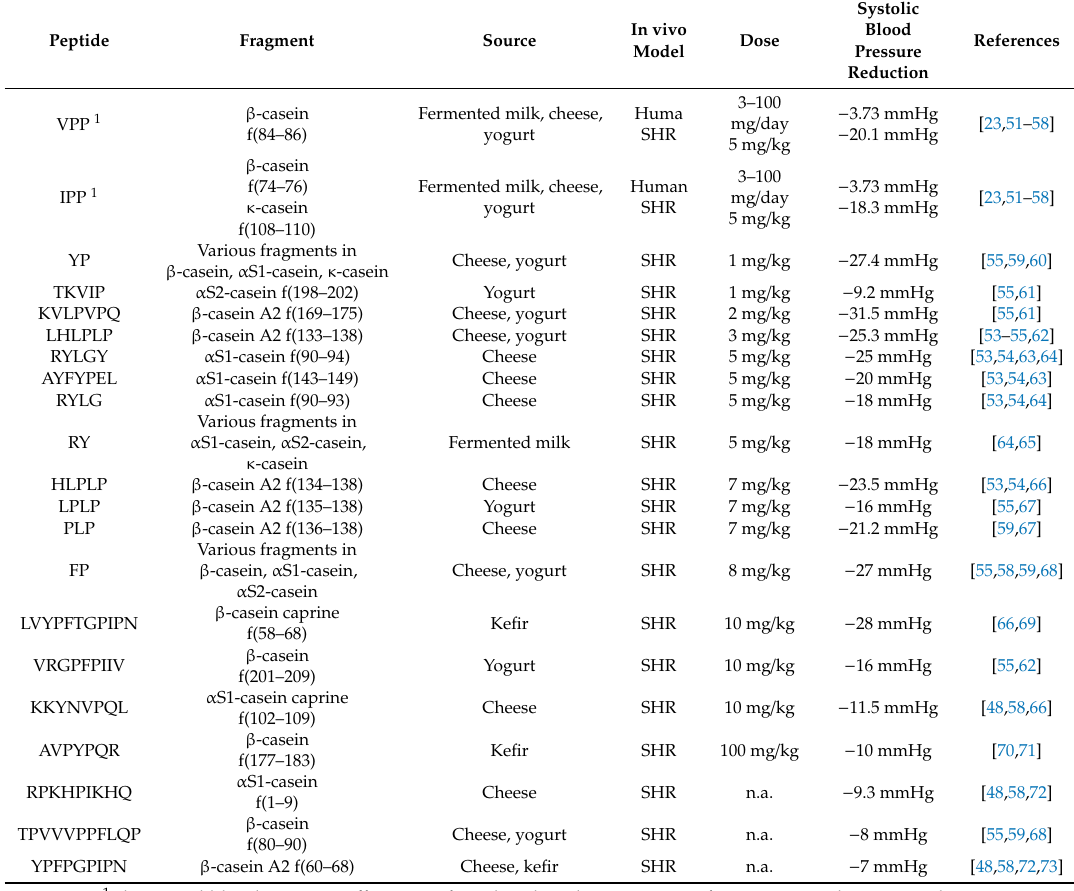
Table 2. Peptides with in vivo anti-hypertensive activity identified in commercial